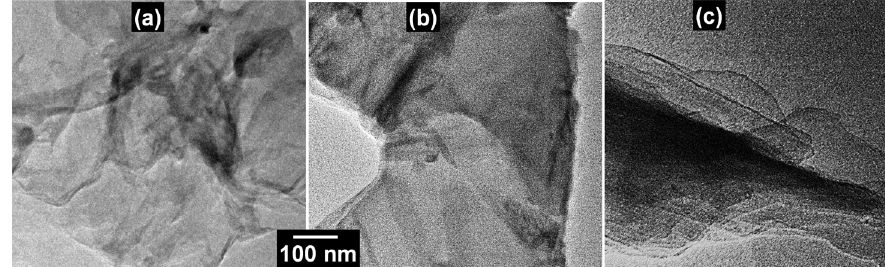
Fig. 5 HRTEM micrograph of (a) GO, (b) GO-ODA, and (c)